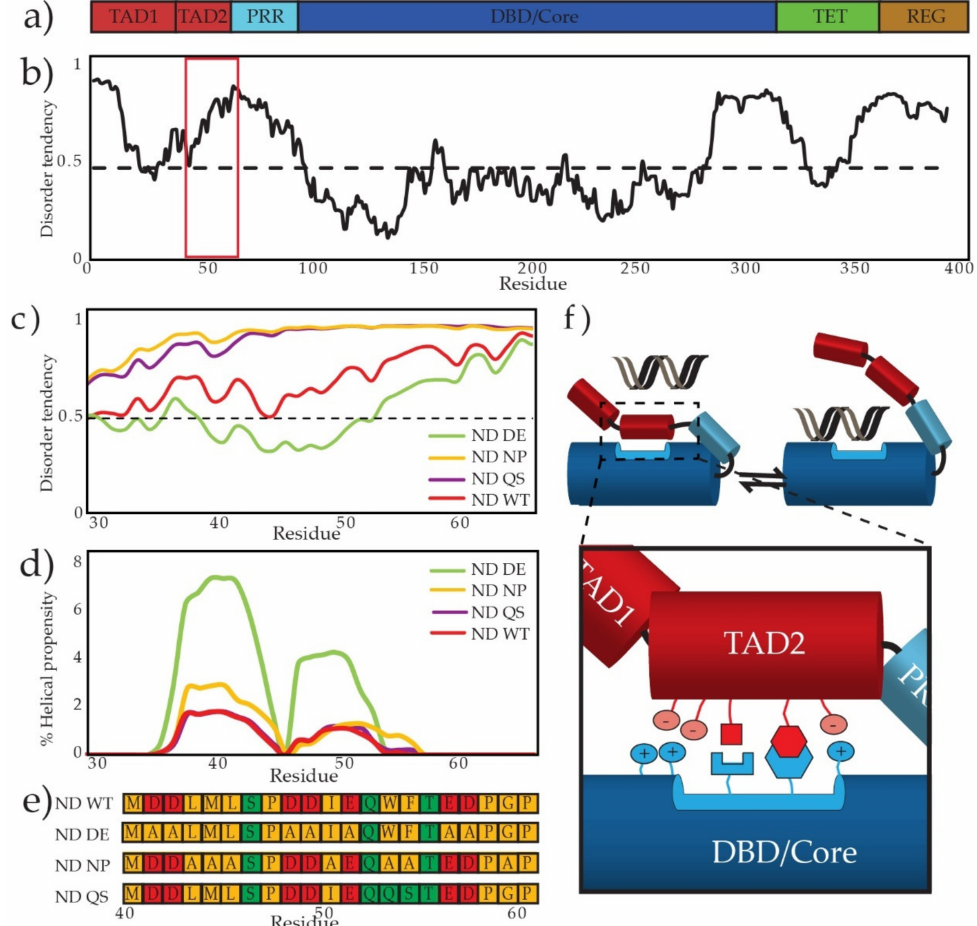
Figure 1. p53’s disordered TAD2 interacts with DBD. ( a ) A domain map shows p53’s domains. ( b ) IUPRED plot of full length p53 WT predicts regions of disorder based on sequence. The red box defines the region containing TAD2. ( c ) Inset from red box in ( b ) of IUPRED plot of a region containing TAD2 compares the disorder prediction of the wild type TAD2 and three mutants, where residues above the 0.5 line are predicted to be disordered. ( d ) Agadir prediction of helical propensity of the TAD2 region using wild type TAD2 and three mutants. ( e ) TAD2 sequences of the WT and mutants used in this study; red boxes indicate negatively charged residues, green boxes indicate polar residues, and gold boxes indicate nonpolar residues. ( f ) TAD2 interacts with DBD, inhibiting DNA binding by a combination a charge-based and specific